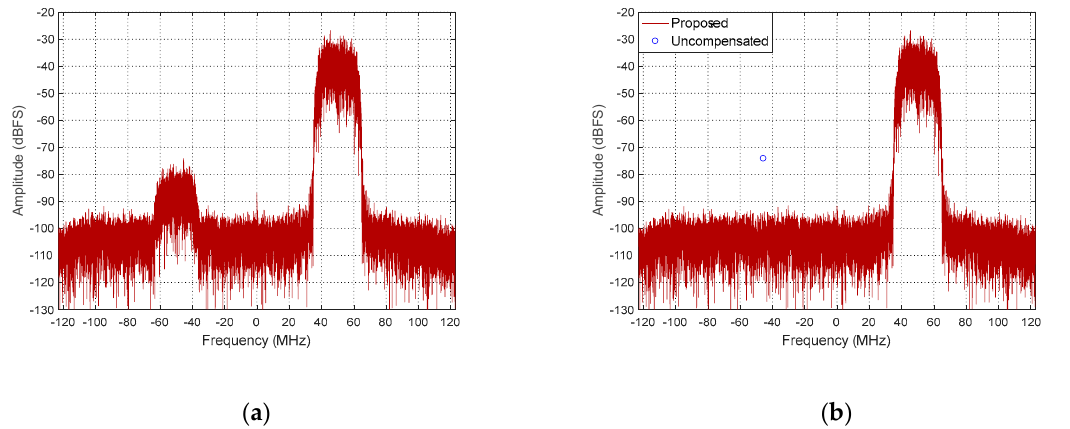
Figure 13. The amplitude spectra of wideband signal: ( a ) before imbalance compensation; ( b ) after imbalance compensation. The number of calibration points N = 64 and the number of signal points 2N 1 = 2.